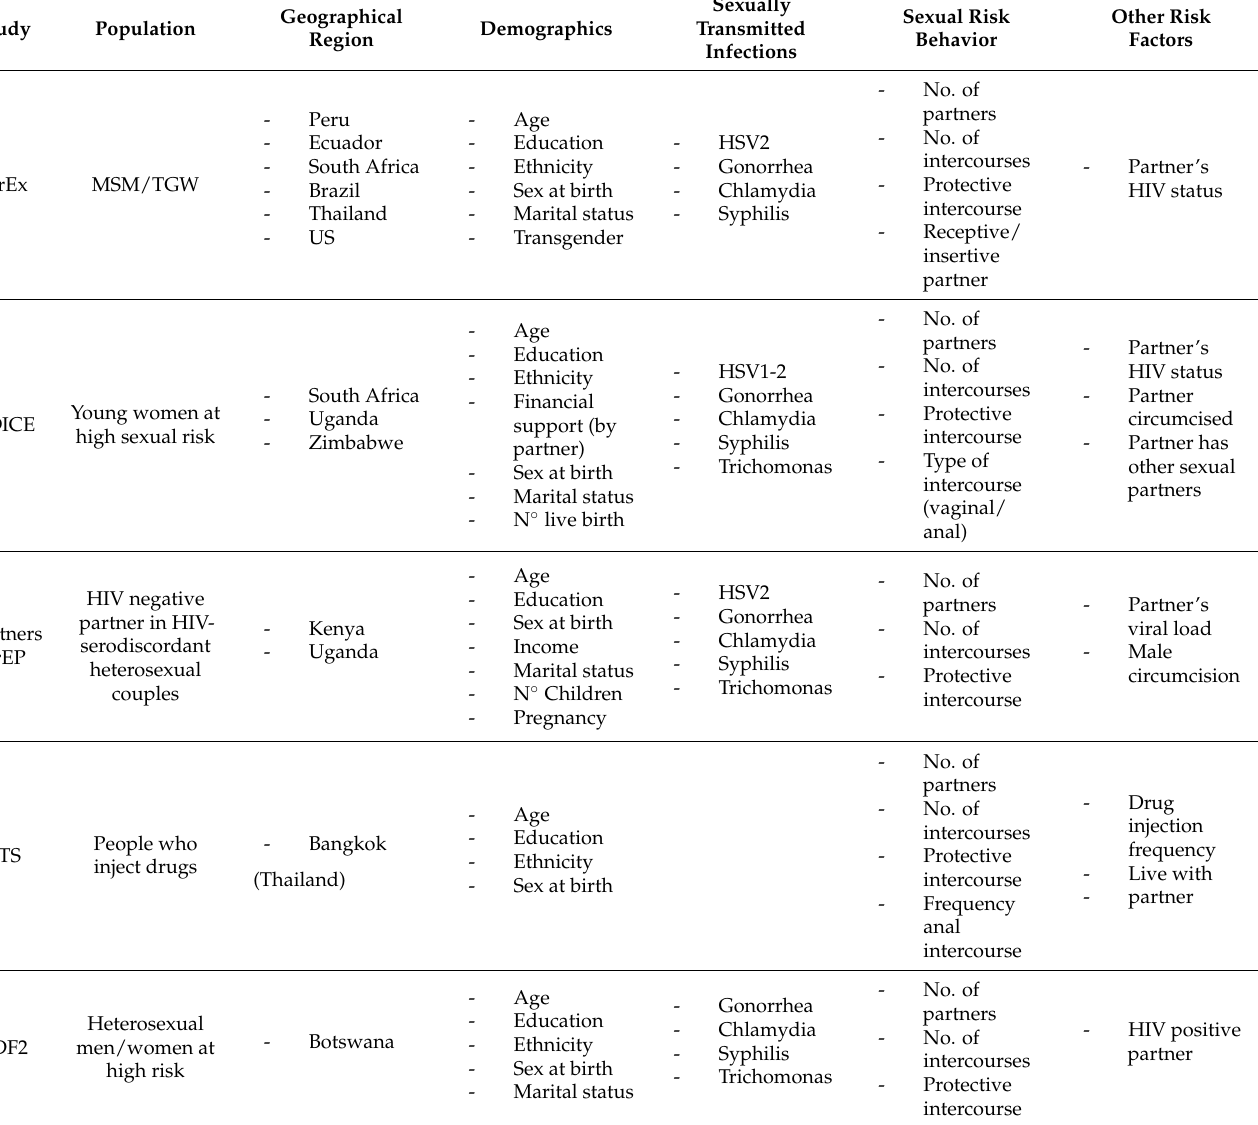
Table 1. Population characteristics and risk factors of participants in five pre-exposure prophylaxis